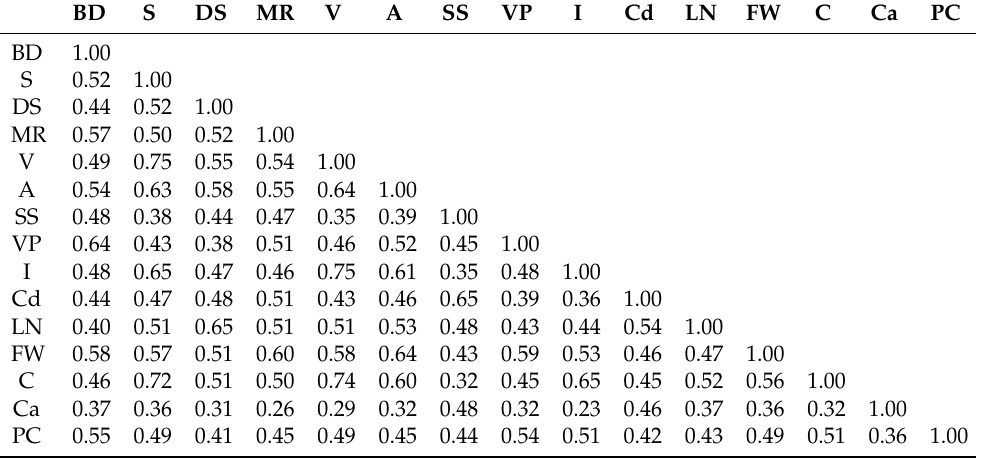
FW = figure weights; C = comparisons; Ca = cancellation; PC = picture completion. N = 1000. Table 3. Uncorrected correlation matrix provided by McFarland (2020): older group.